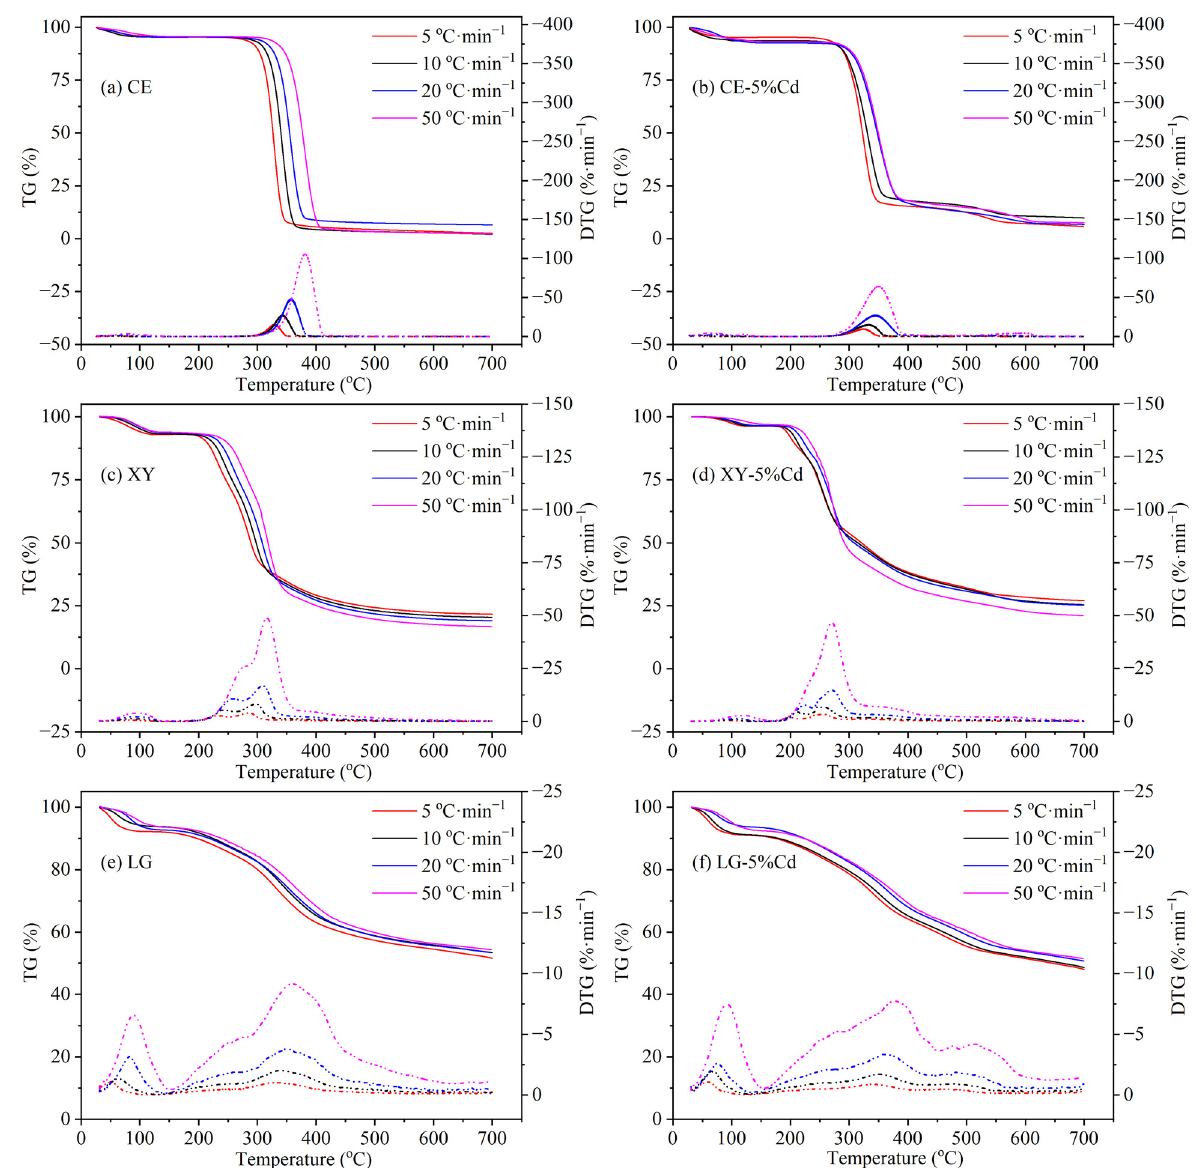
Figure 1. TG/DTG curves of three model components at different heating rates. ( a , c , e ) are the control groups; ( b , d , f ) are the Cd-concentrated biomass with a Cd loading of 5% (wt.%). The pyrolysis behavior of the three Cd-concentrated model components is obviously changed. As shown in Figure 1b, the TG/DTG curves of Cd-concentrated cellulose are shifted to the low-temperature region. Taking 5 °C·min − 1 for instance, the T s (the starting temperature of pyrolysis) is decreased from 282 to 267 °C and the T m (the temperature of maximum pyrolysis velocity) is decreased from 329 to 325 °C, indicating that Cd pro- motes the initial pyrolysis of cellulose at low temperature. Similar results reported by Mayer et al. [20] demonstrated that Zn 2+ and Fe 3+ also catalyzed the cellulose degradation with a decreased pyrolysis temperature of 4–9 °C, while Ca 2+ and Pb 2+ inhibited the cel- lulose degradation with an increased pyrolysis temperature of 1–4 °C. Importantly, the above movement trend caused by Cd is more pronounced at the higher heating rate conditions, which indicates that Cd acts as a heat medium during the pyrolysis reaction and greatly reduces the thermal hysteresis effect by increasing the heating rate [38]. In addition, Cd also reduces the peak value of the DTG curve of which R m (the maximum pyrolysis velocity) is decreased from 14.9 to 9.44%·min − 1 . Generally, active cellulose is